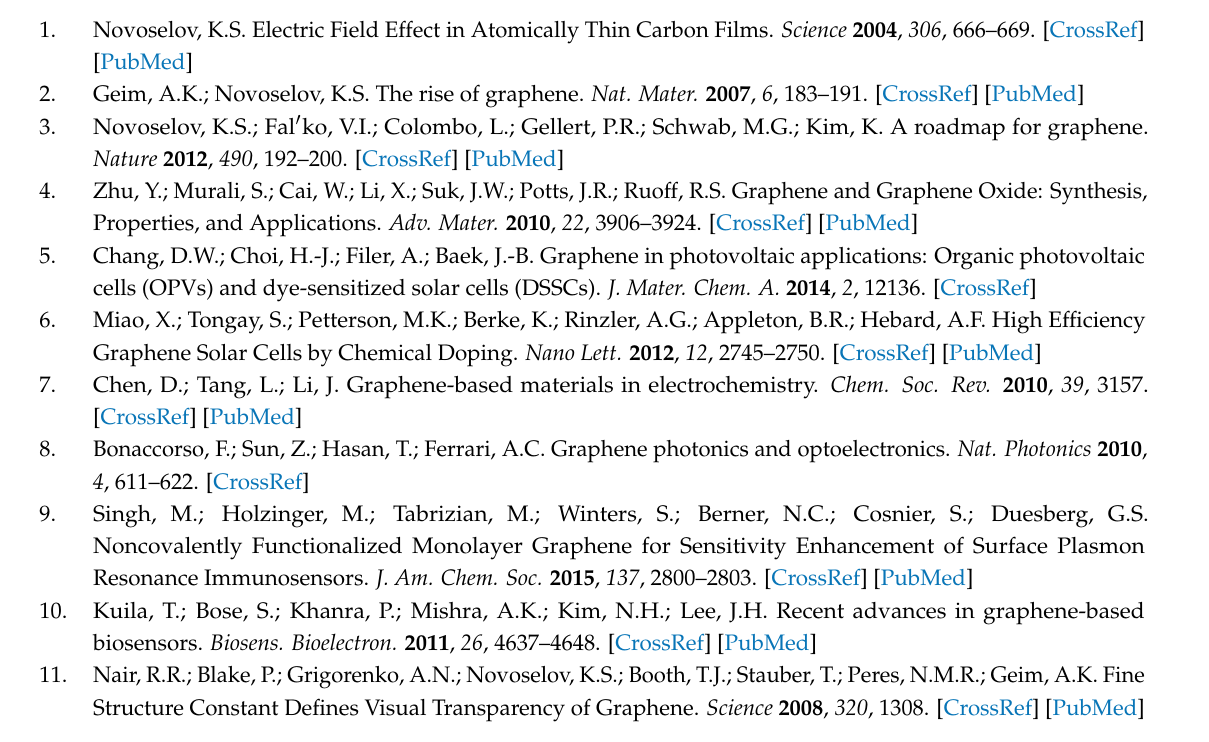
s1, Figure S1: Raman spectrum measured for the graphene substrate used in the experiments, Figure S2: SEM image of a dropcasted graphene oxide dispersion, Figure S3: Photography of a GO aqueous dispersion. The sample was illuminated from the back with a polarized light source (direction of the polarization is indicated by the arrow on the right). Half of the sample was covered with an additional polarizer as indicated on the left. Bright areas in the two-crossed polarizers area evidence liquid crystalline character of the sample, Figure S4: Glass coverslips with spin coated graphene oxide before (one the left) and after (on the right) thermal reduction, Figure S5: Transmission map compared with the map of fluorescence intensity ratio measured for PSI complexes on rGO excited with 405 nm and 535 nm excitation